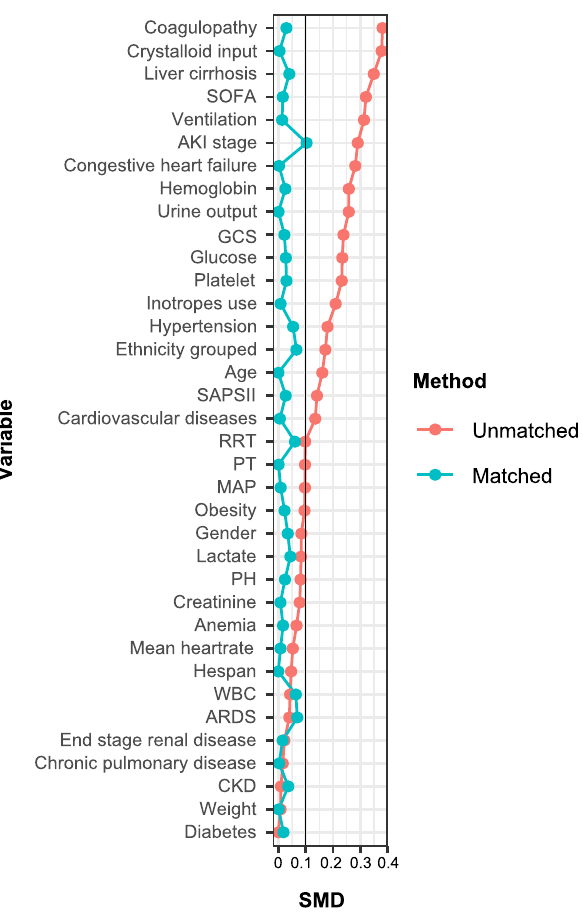
Figure 2. Standardized mean difference (SMD) of variables before and after propensity score matching. SOFA Sequential Organ Failure Assessment; AKI acute kidney injury; GCS Glasgow Coma Scale; SAPSII Simplified Acute Physiology Score II; RRT renal replacement therapy; PT prothrombin time; MAP mean arterial pressure; WBC white blood cell; ARDS acute respiratory distress syndrome. Statistical analysis was performed using R 4.0.0